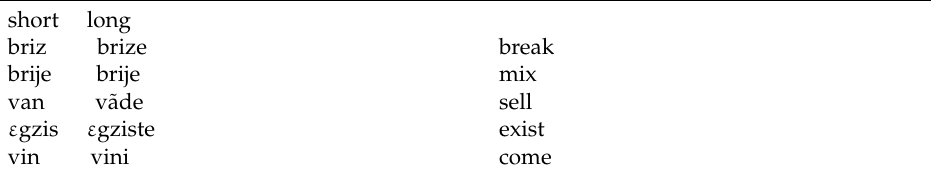
Table 2. Short and long verb forms in Mauritian Creole